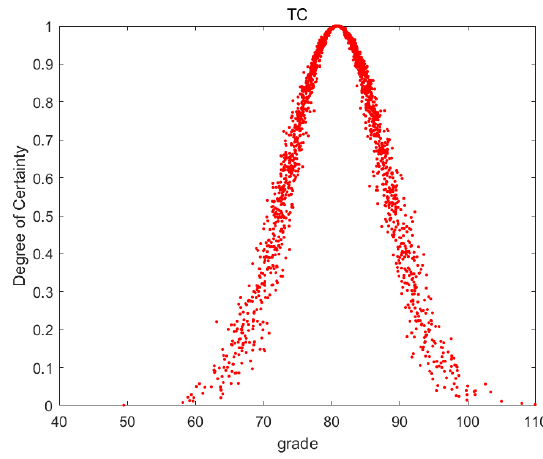
Figure 4. Cloud image of TC.